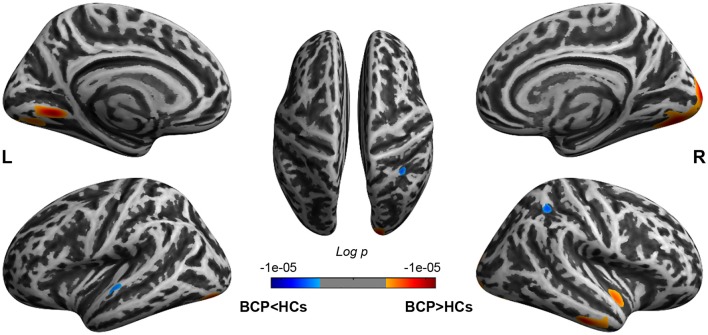
Brain regions show CT differences between BCP and HCs. The thicker cortices are observed in the bilateral hemispheres (lateral occipital, lingual, fusiform), and right hemisphere (cuneus, peri calcarine, inferior temporal, middle temporal, superior temporal, insula). The thinner cortices are observed mainly in the left superior temporal and right superior parietal regions. CT, cortical thickness; BCP, bilateral cerebral palsy; HCs, healthy controls; L, left; R, right.